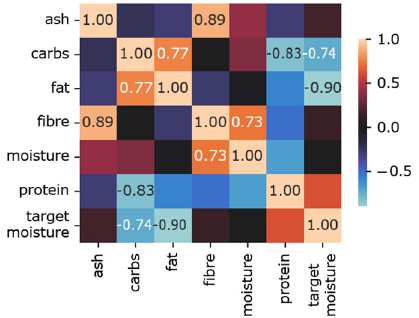
Figure 9. Correlation matrix of constituents in meat analogs.